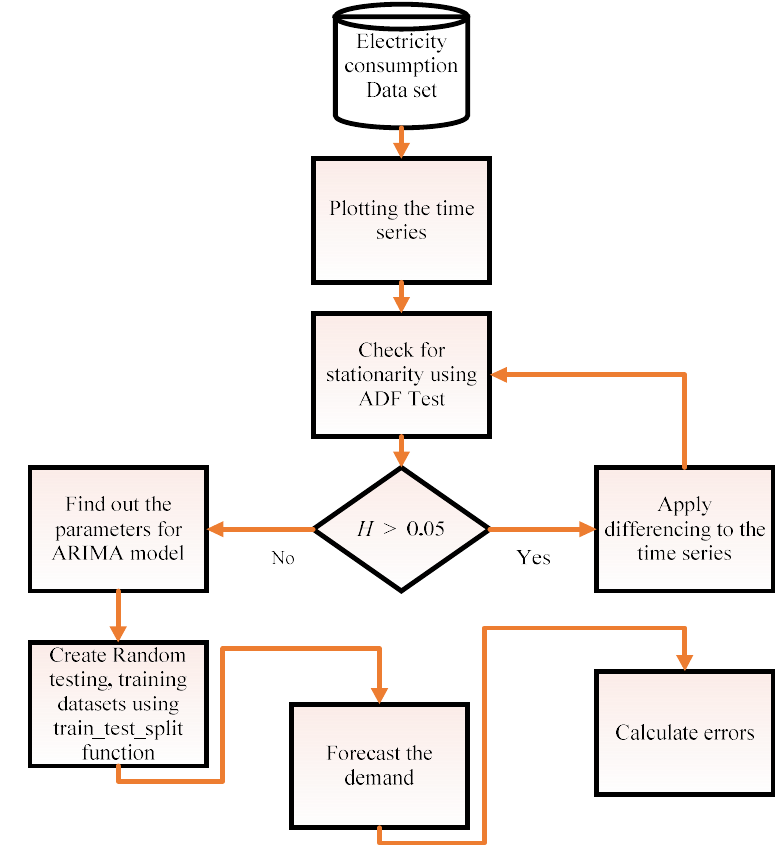
Figure 2. Architectural view of the ARIMA model.